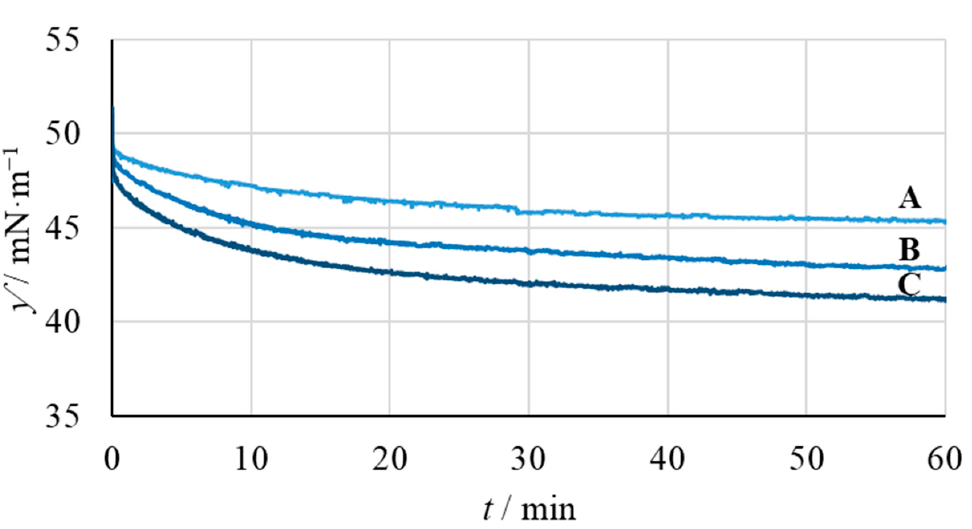
Figure 1. The IFT evolution vs. time of the heptane/water interface in the presence of the Janus nanoparticles (50 mg/mL in the aqueous phase) of the homologous series (A) JNP-bPEI 2 mL, (B) JNP-bPEI 3 mL, (C) JNP-bPEI 4 mL.